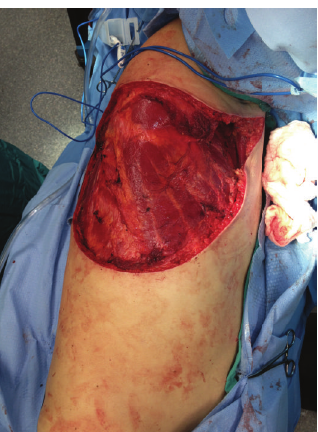
Figure 3: Intraoperative picture after wide local excision and right axillary lymph node dissection.